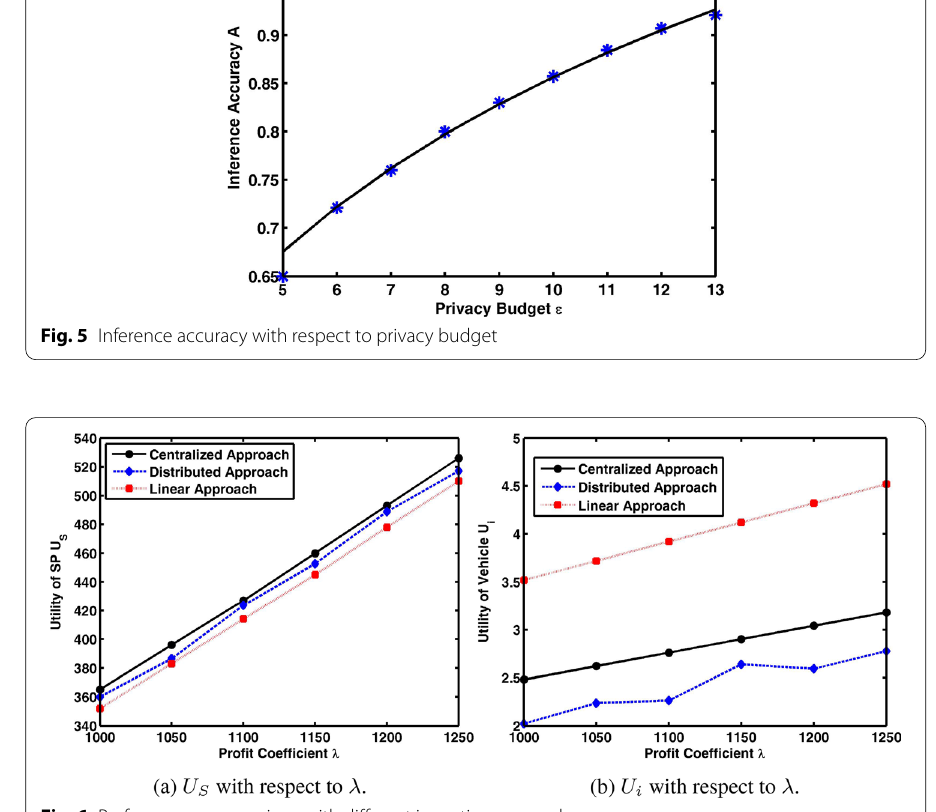
Fig. 6 Performance comparison with different incentive